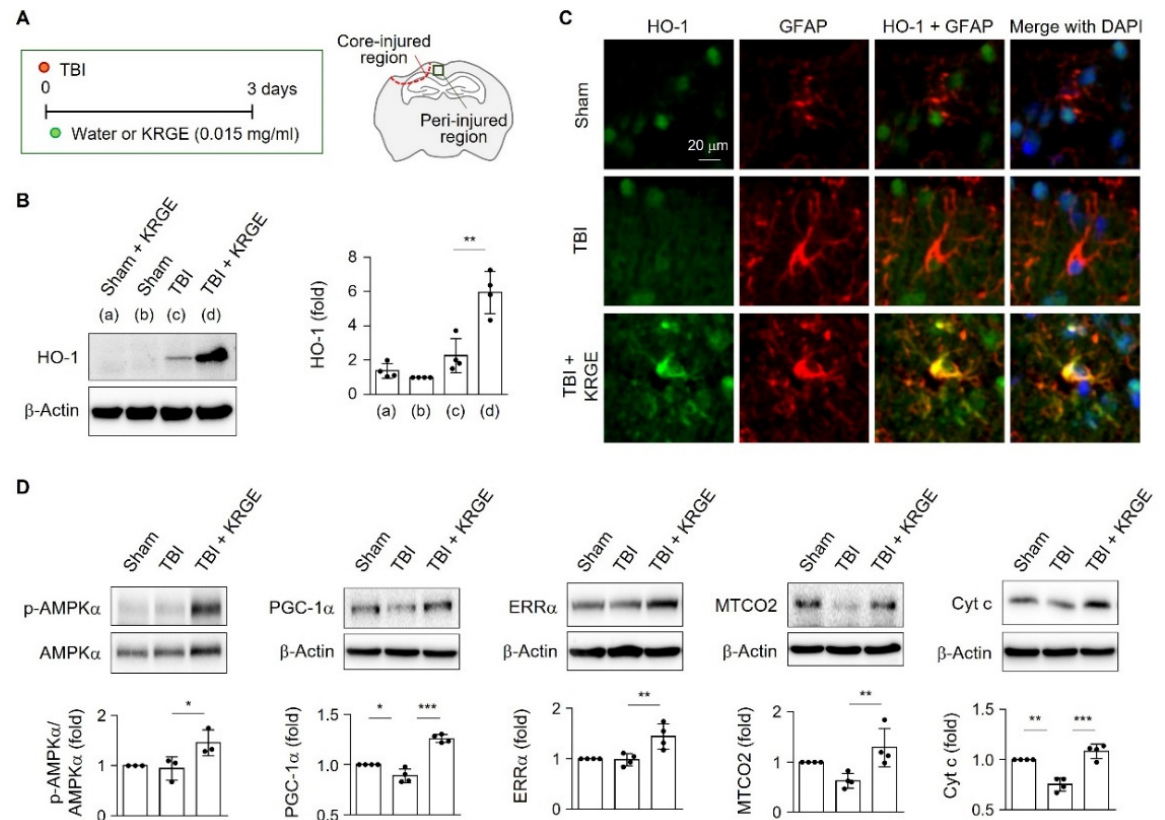
Figure 1. Astrocytic heme oxygenase-1 (HO-1) was expressed in the peri-injured region of a mouse brain with traumatic brain injury (TBI). ( A ) Schematic representation of TBI conditions and Korean red ginseng extract (KRGE) administration (left). Figure for the TBI brain section demonstrates core-injured and peri-injured regions (right). ( B – D ) HO-1 protein expression in brain tissues (approximately bregma − 1 to − 2) was detected in the peri-injured region of the TBI ipsilateral brain. ( B ) HO-1 protein expression was assessed by Western blotting. β -Actin was used as the internal control ( n = 4). ( C ) Representative image of HO-1 (green) and glial fibrillary acidic protein (GFAP, red) expression in a mouse subjected to TBI ( n = 3 per group). Scale bar = 20 μ m. ( D ) Protein expression in brain sections obtained from sham, TBI, and TBI followed by KRGE (TBI + KRGE) was detected using the indicated antibodies and assessed by Western blotting ( n = 3 or 4 per group). * p < 0.05; ** p < 0.01; *** p < 0.001.